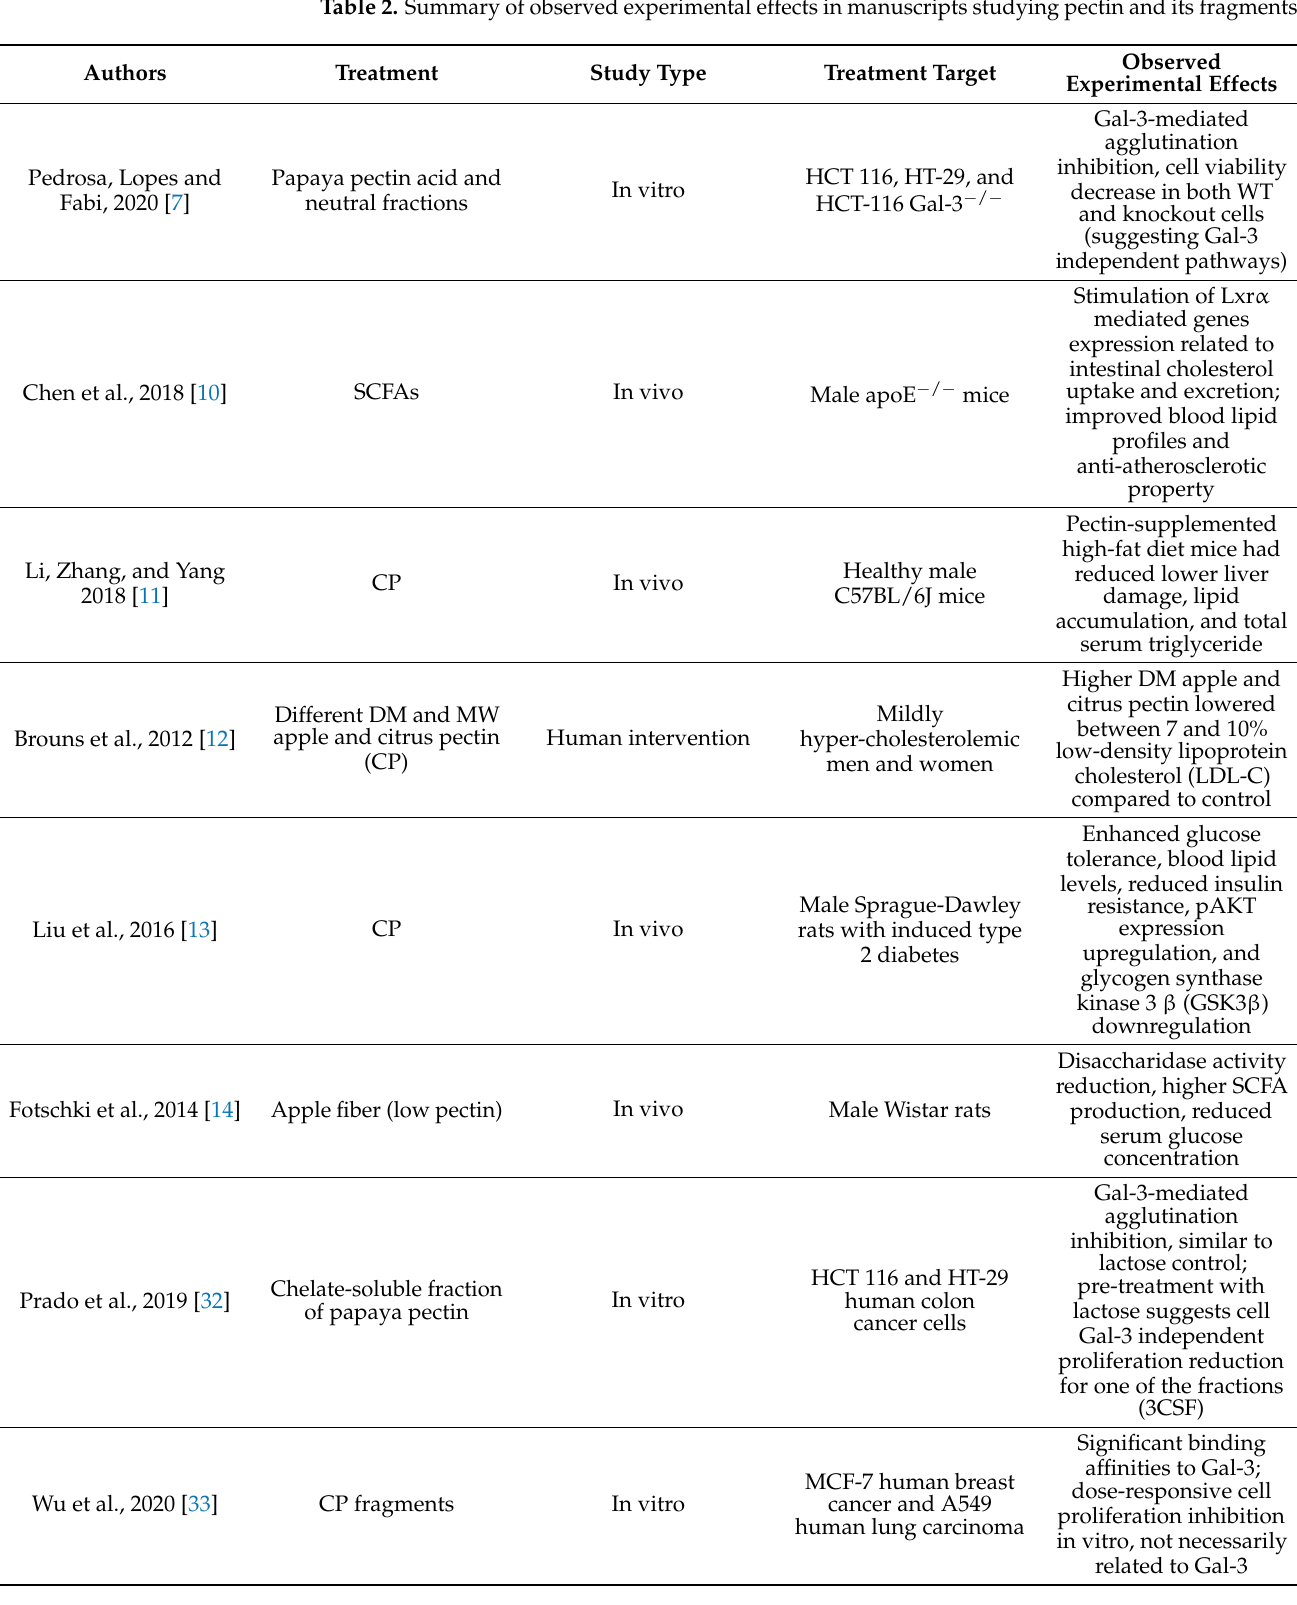
Table 2. Summary of observed experimental effects in manuscripts studying pectin and its